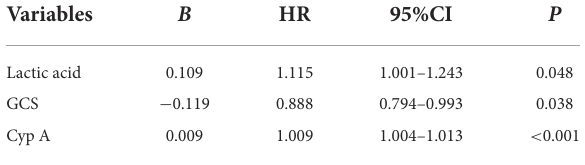
TABLE 6 Multivariable cox proportional hazard regression analysis of the risk factors for death of craniocerebral traumatic patients.